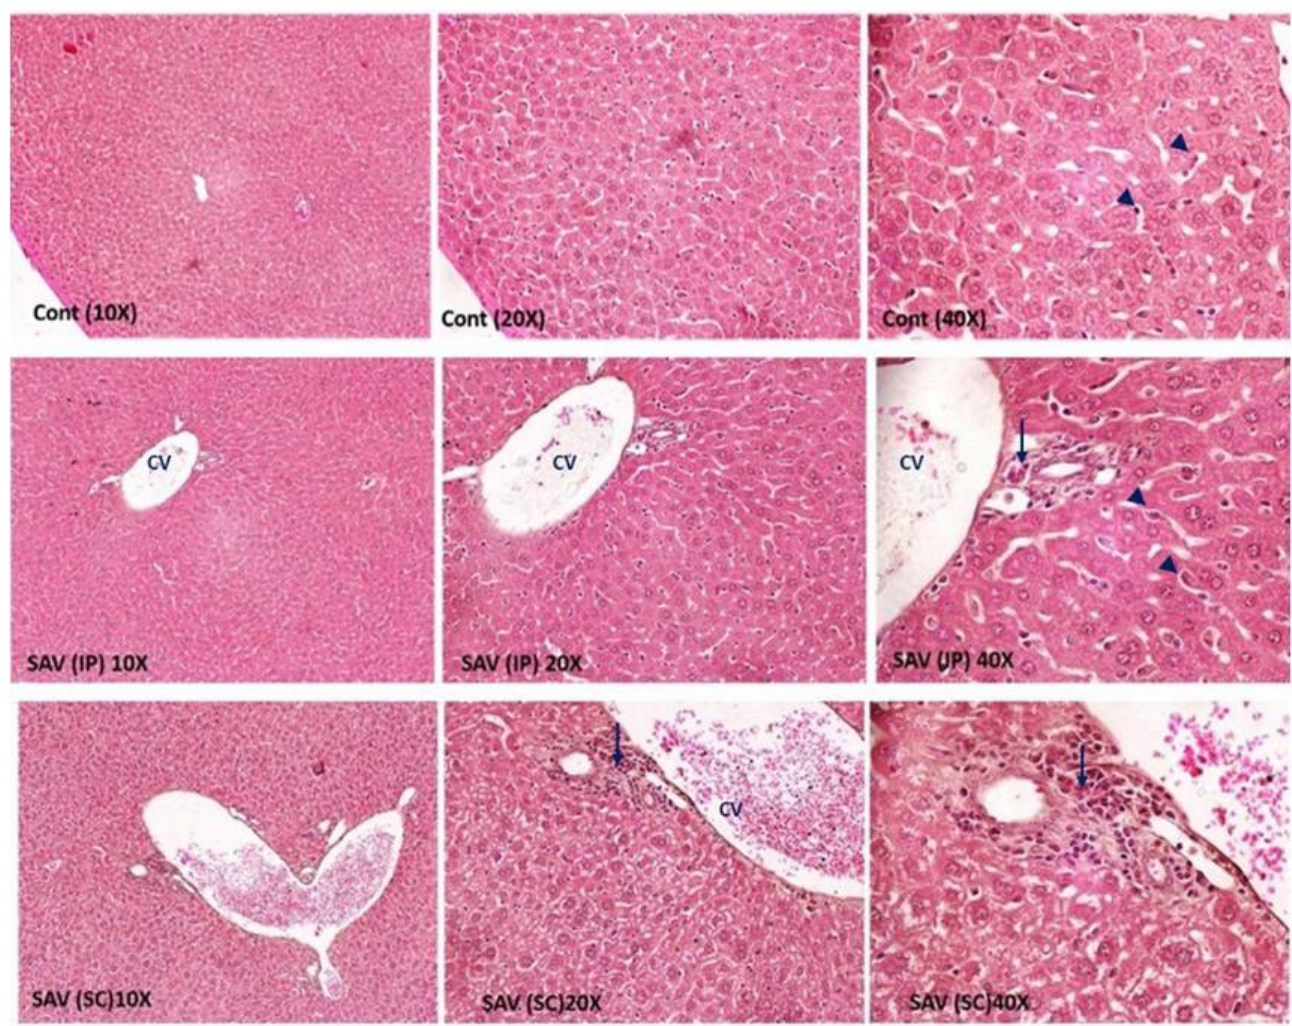
Figure 8. Representative photomicrographs of liver tissue. Each group has three magnifications (10×, 20×, 40× and HE). Arrows indicate inflammatory cells whereas arrow heads show Kuppffer’s cells. CV: central vein, Cont: control group, SAV: samsum ant venom, IP: intraperitoneal, SC: